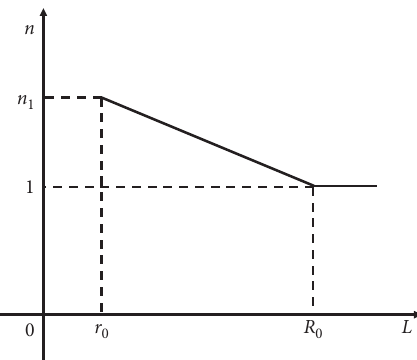
Figure 5: Variation of dilatancy coefficient around the drilling hole in the elastic